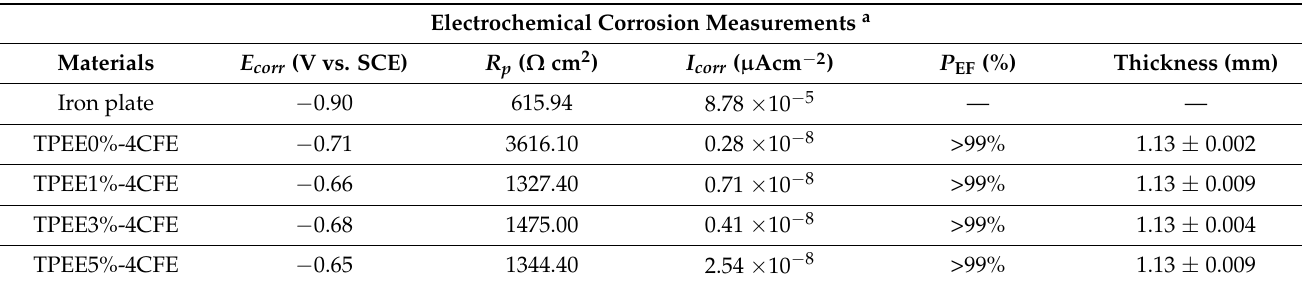
Table 2. Electrochemical corrosion measurements of a bare iron plate and TPEEn%-4CFE.